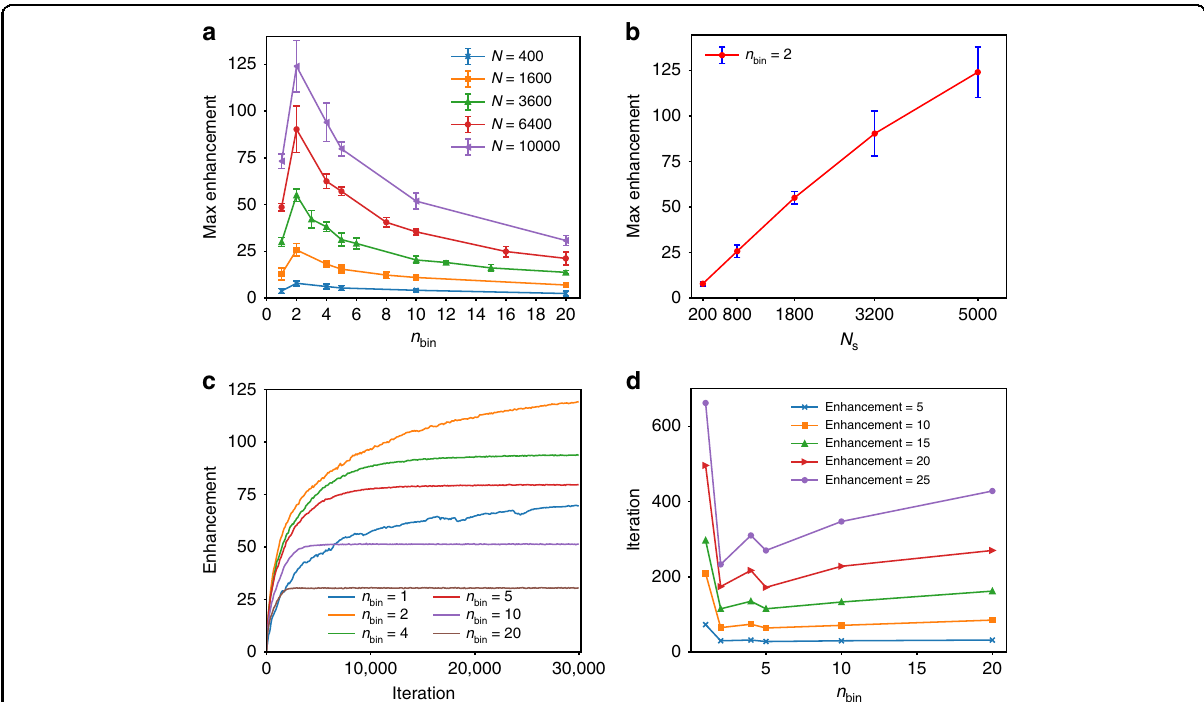
Fig. 4 Optimization curves in terms of n bin and N s . a Relations between the maximum of enhancements and n bin , if the number of DMD pixels N are 400, 1600, 3600, 6400, and 10,000, respectively. n bin = 1 represents the binary encoding. b Maximum of enhancements as a function of the number of modulation modes when n bin = 2. Standard deviation over 10 data sets was indicated by the error bars. c Optimization curves with respect to various n bin when N = 10,000. d Relations between the number of iterations to obtain a certain enhancement and n bin . We chose the enhancements equal to 5, 10, 15, 20, and 25 for demonstration. N = 10,000.